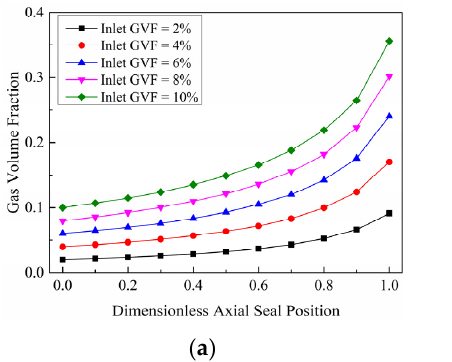
Figure 4. GVF distribution characteristics along the axial direction under different operating conditions. ( a ) GVF under different inlet GVFs for Δ P = 31 bars, ( b ) GVF under different pressure differences for inlet GVF = 10%.